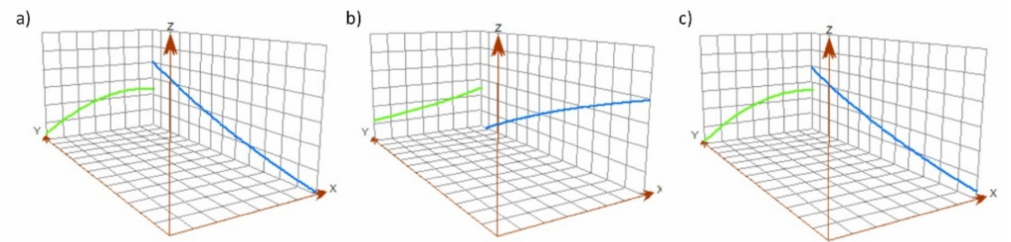
Figure 4. Trend analysis polynomials for the historical period (1971–2000) for ( a ) HDD, ( b ) CDD, and ( c ) HDD + CDD, in which East–West trend is represented by the green line, the North–South by the blue line and z-axis represents the variable